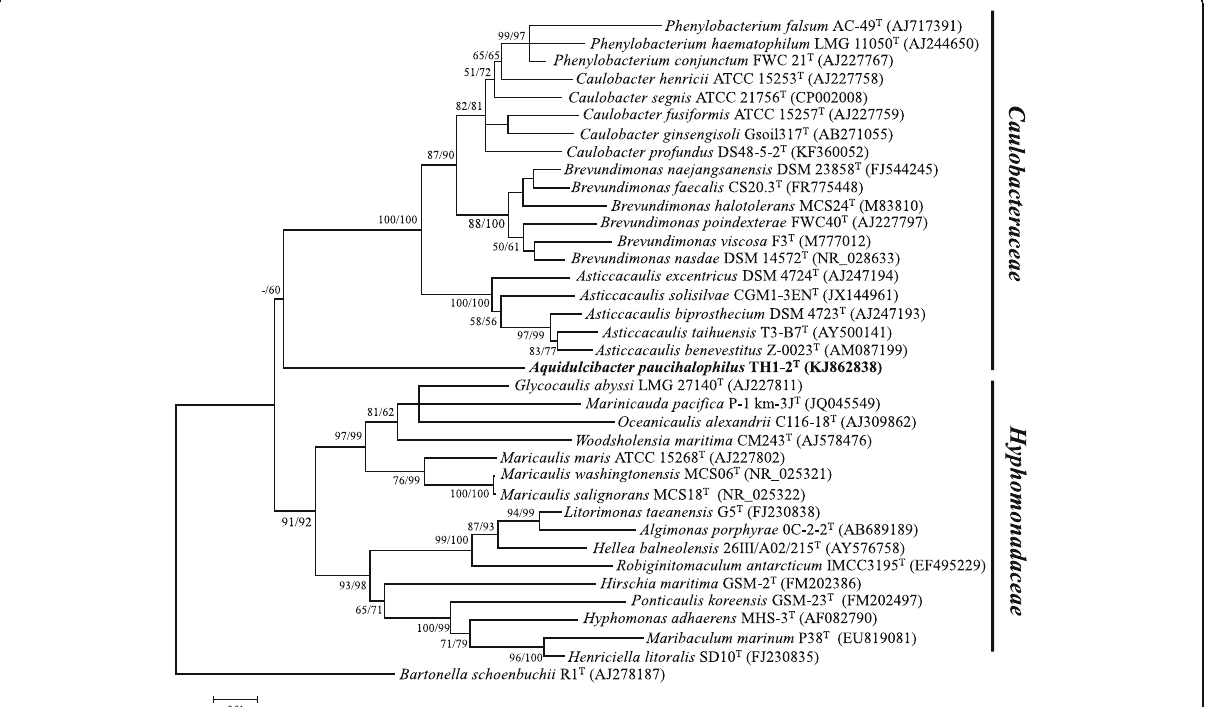
Fig. 1 The 16S rRNA tree highlighting the position of A. paucihalophilus TH1 – 2 T relative to the representatives of the order Caulobacterales including the families Caulobacteraceae and Hyphomonadaceae . Maximum likelihood (substitution model=GTR) tree, using 1406 aligned characters, was rooted by Bartonella schoenbuchii R1. Branches were scaled in terms of the expected number of substitutions per site. Numbers adjacent to branches are support values from 1000 ML bootstrap replicates (left) and from 1000 maximum-parsimony bootstrap replicates (right); values below 50% were